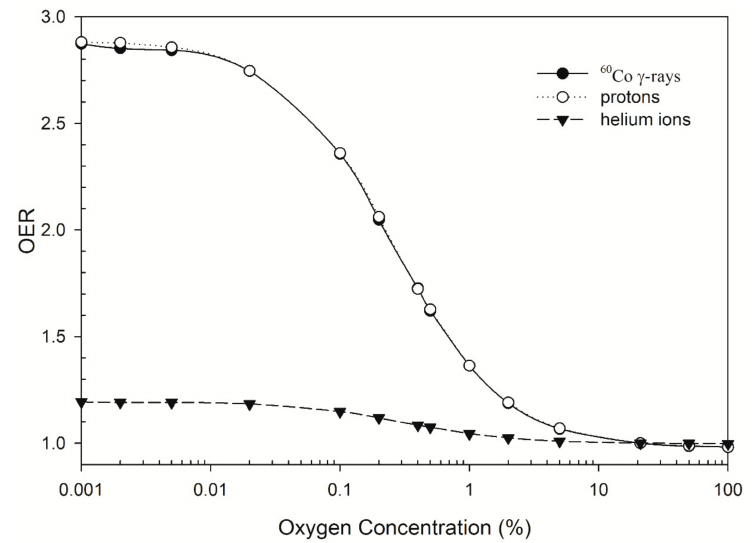
Figure 2. Oxygen enhancement ratio (OER) as a function of oxygen concentration (0.001–100% O 2 ). MCDS-derived OER values were plotted for cells irradiated by 60 Co γ -rays (LET = 2.4 keV/ µ m), 62 MeV proton ions (LET = 1.051 keV/ µ m) and 3.31 MeV helium ions (LET = 120 keV/ µ